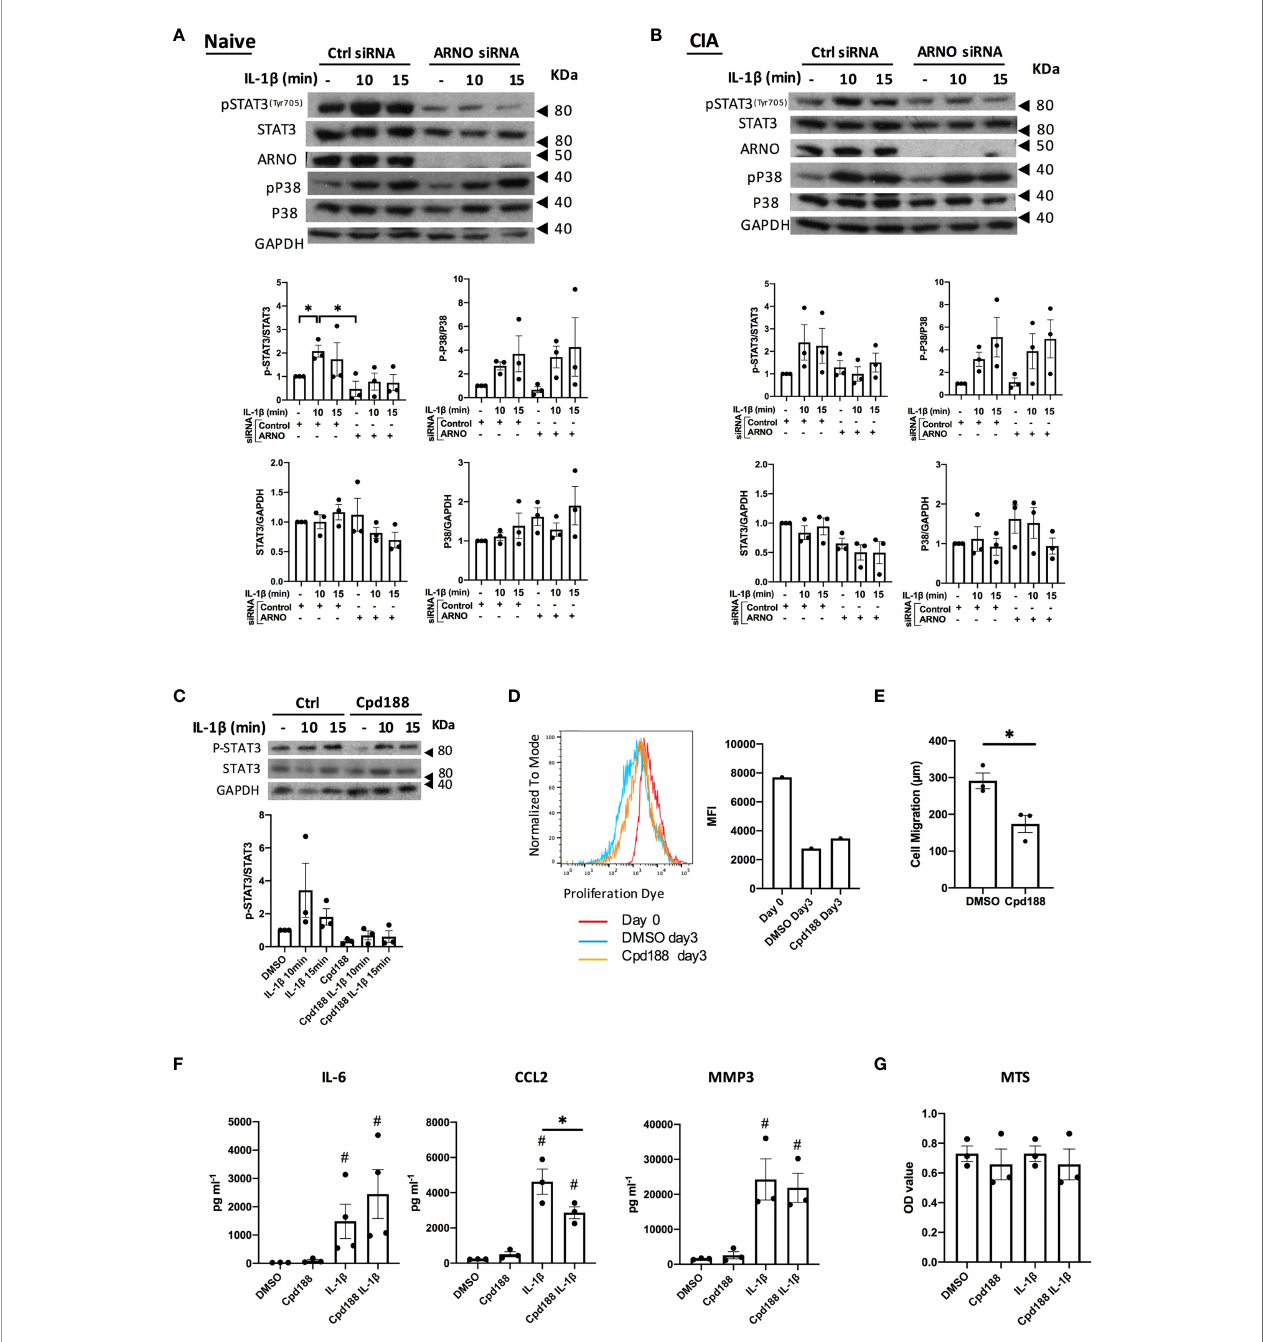
FIGURE 4 | ARNO is required for STAT3 phosphorylation in SFs. Representative Western blots of the naïve (A) and CIA (B) SFs treated with control and ARNO siRNA followed by IL-1 b stimulation (10 ng/ml) at indicated times. Anti-pSTAT3 Tyr705 , STAT3, ARNO, p-p38, p38 and GAPDH antibodies were used. Graphs show the relative quanti fi cation of phosphorylated STAT3 and p38 in naïve SFs and CIA SFs, calculated as pSTAT3/STAT3 and p-p38/p38 band intensity, and changes in total protein expression were calculated as STAT3/GAPDH and p38/GAPDH. Error bars represent SEM (n=3). Each dot represents one independent experiment. *p < 0.05 by Mann-Whitney test. (C) Representative Western blots and quanti fi cation of phosphorylated and total STAT3 in control (DMSO) and Cpd188 (STAT3 inhibitor, 73uM) treated naïve SFs followed by IL-1 b stimulation at indicated times (n=3). (D) Mean fl uorescence intensity of proliferation dye in SFs cultured for 3 days after treated with Cpd188 compared to control SFs. (E) Migration distance of SFs was measured 24 hours after Cpd188 treatment, error bars represent SEM (n=3). *p < 0.05. (F) Control or Cpd188-treated SFs were stimulated by IL-1 b (24h), when cell supernatants were collected to analyse cytokine secretion by ELISA. # p < 0.05 versus unstimulated control, statistical signi fi cance was evaluated by the Mann-Whitney test. (G) cell viability was assessed using MTS cell proliferation kit. In all cases, one dot represents one individual experiment, analysed in triplicate for ELISA and MTS